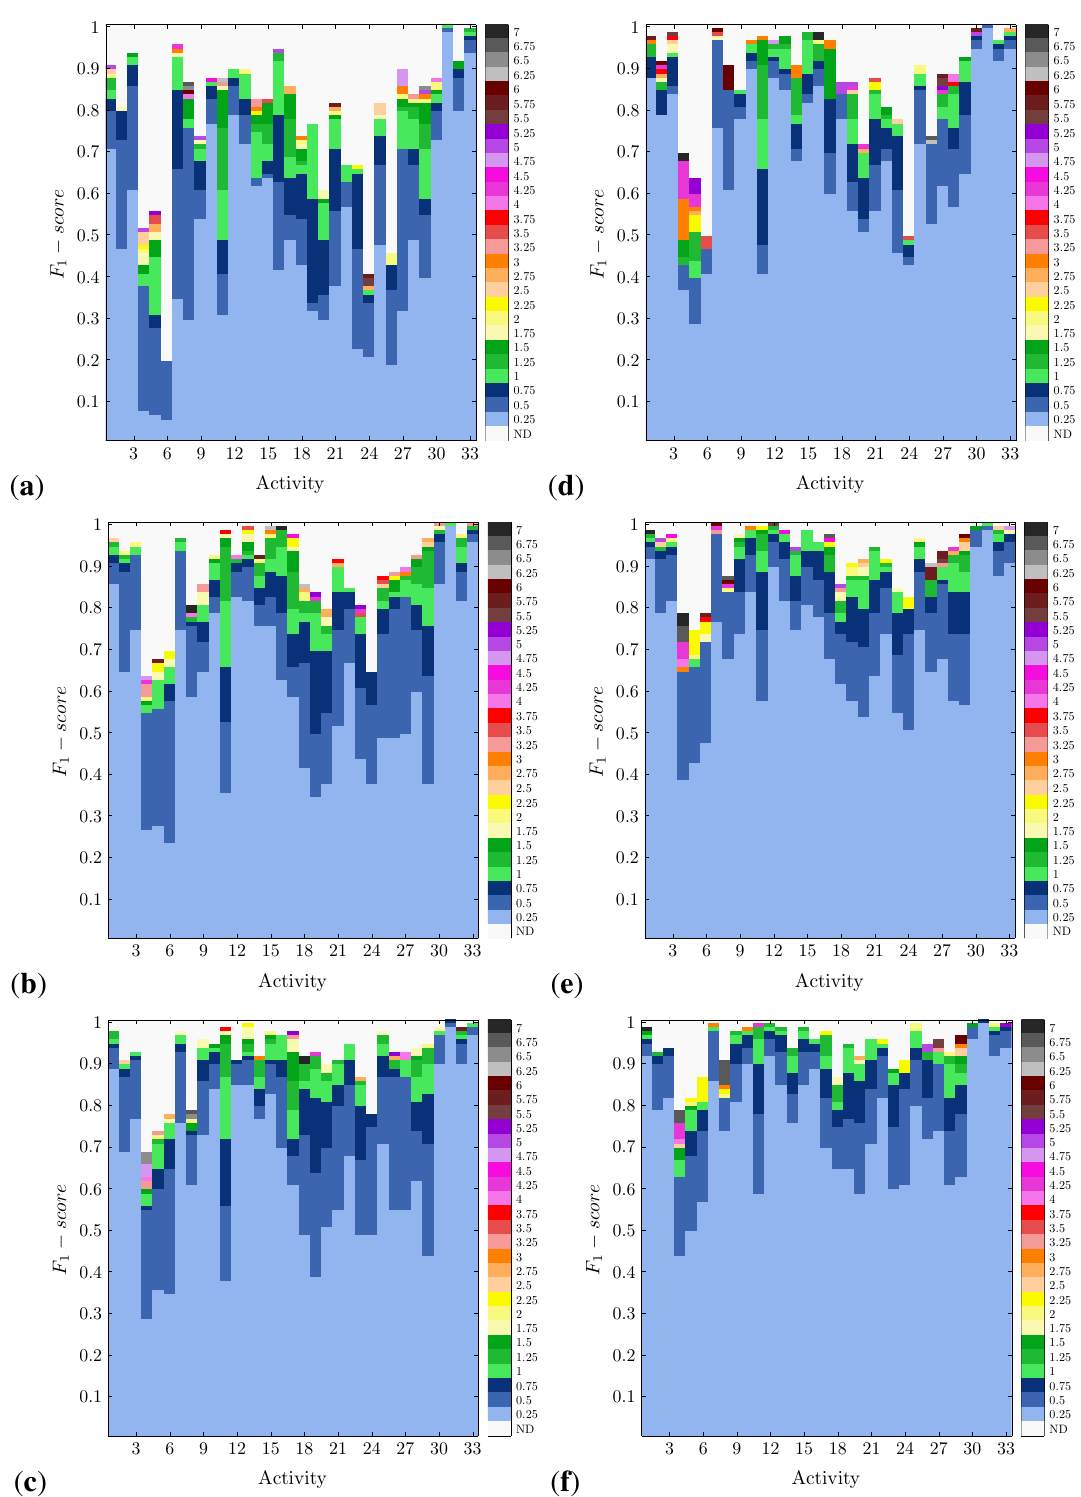
Figure 4. Activity-specific recognition performance for diverse window sizes and methodologies ( < classification paradigm > - < feature set > ): ( a ) NCC-FS1; ( b ) NCC-FS2; ( c ) NCC-FS3; ( d ) NB-FS1; ( e ) NB-FS2; and ( f ) NB-FS3. The minimum window